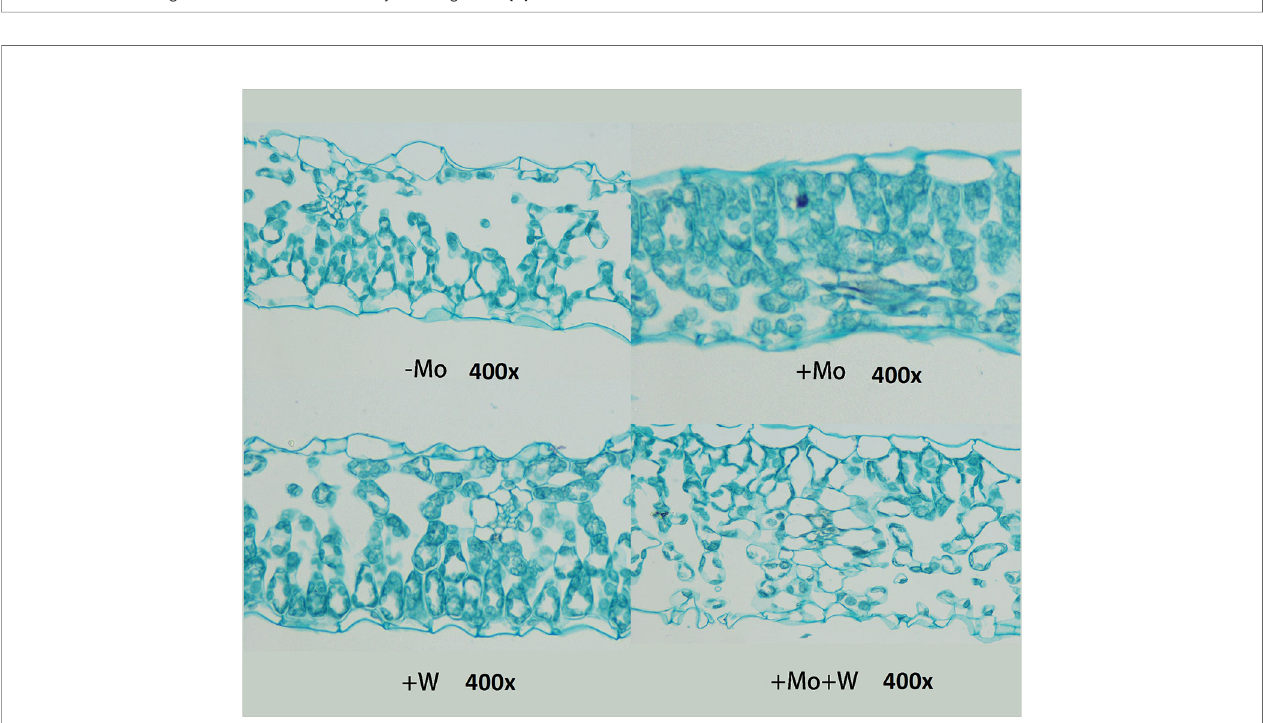
FIGURE 4 | Effect of solid MS culture medium with Na 2 MoO 4 or Na 2 WO 4 on the microstructure of strawberry seedling